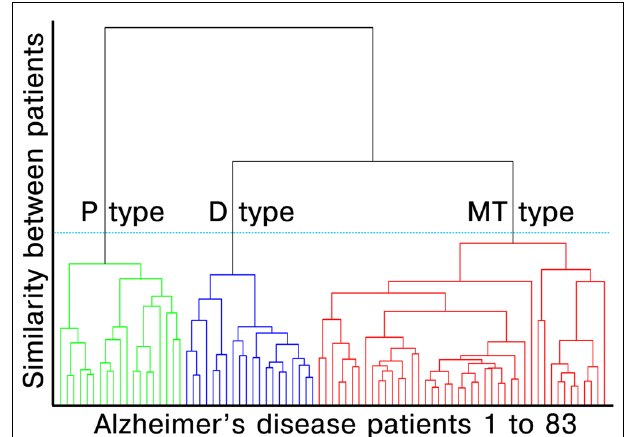
FIGURE 1 | Dendrogram created by surface-based multimodal cluster analysis. AD, Alzheimer’s disease; MT, medial temporal-dominant; P, Parietal-dominant; D, Diffuse atrophy. The distance along the y-axis represents the measure of similarity between patients, such that the shorter the distance, the greater the similarity between patients. The green, blue and red lines represent the clustered subtypes of AD dementia. The three clusters were selected based on Gap statistics (see Appendix 2 in Supplementary Materials